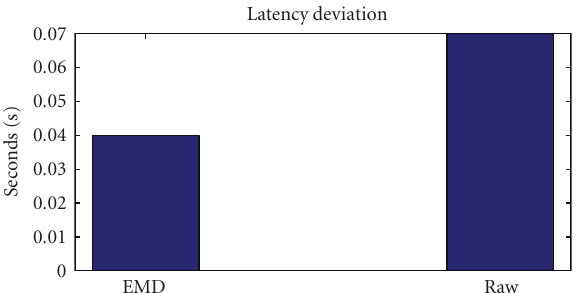
Figure 9: Bar graph comparison of latency deviation for EMD- based and raw single trials. Lower latency deviation indicates better performance.